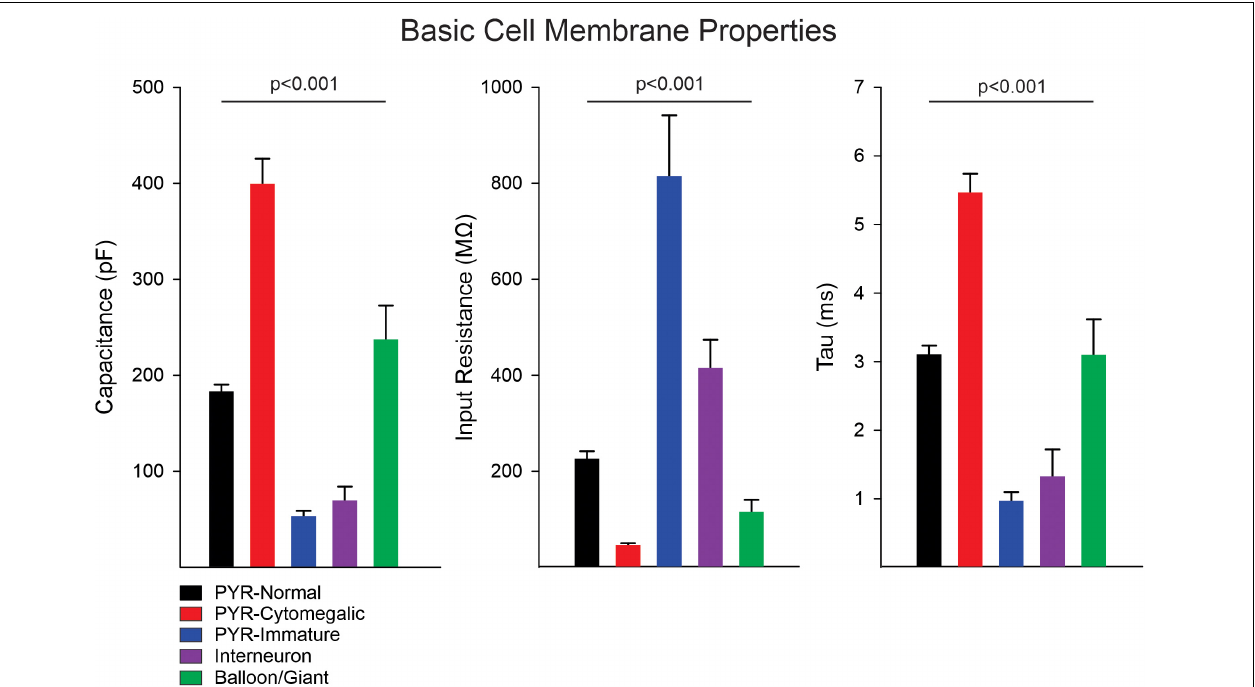
FIGURE 1 | Membrane properties of the different cell types. Measurement of basic cell membrane properties (capacitance, input resistance, and time constant) in voltage clamp mode demonstrated statistically significant differences among cell groups ( p < 0.001, one-way ANOVA on Ranks). The cell capacitance of cytomegalic pyramidal neurons was significantly larger than that of normal CPNs, immature pyramidal neurons, and interneurons (all at p < 0.001, pairwise multiple comparisons using Dunn’s method), whereas it was not different from that of balloon/giant cells ( p = 0.3). Similarly, the cell capacitance of normal CPNs and balloon/giant cells was larger than that of interneurons and immature CPNs (both at p < 0.001). Comparison of cell capacitance between balloon/giant cells and normal CPNs or that between interneurons and immature CPNs was not significantly different. In contrast, the membrane input resistance of cytomegalic CPNs was significantly lower than that of normal and immature CPNs, as well as interneurons (all at p < 0.001). The input resistance of cytomegalic and normal CPNs compared with balloon/giant cells was not significantly different (both at p = 0.6). Immature CPNs had significantly higher input resistance compared with that of normal CPNs and balloon/giant cells (both at p < 0.001) but not different from that of cortical interneurons. Finally, the input resistance of interneurons was significantly higher than that of balloon/giant cells ( p = 0.004) and normal CPNs ( p = 0.02). The differences in time constant were similar to those in cell capacitance, except for the comparison between cytomegalic CPNs and balloon/giant cells, which was significantly lower in the latter ( p <